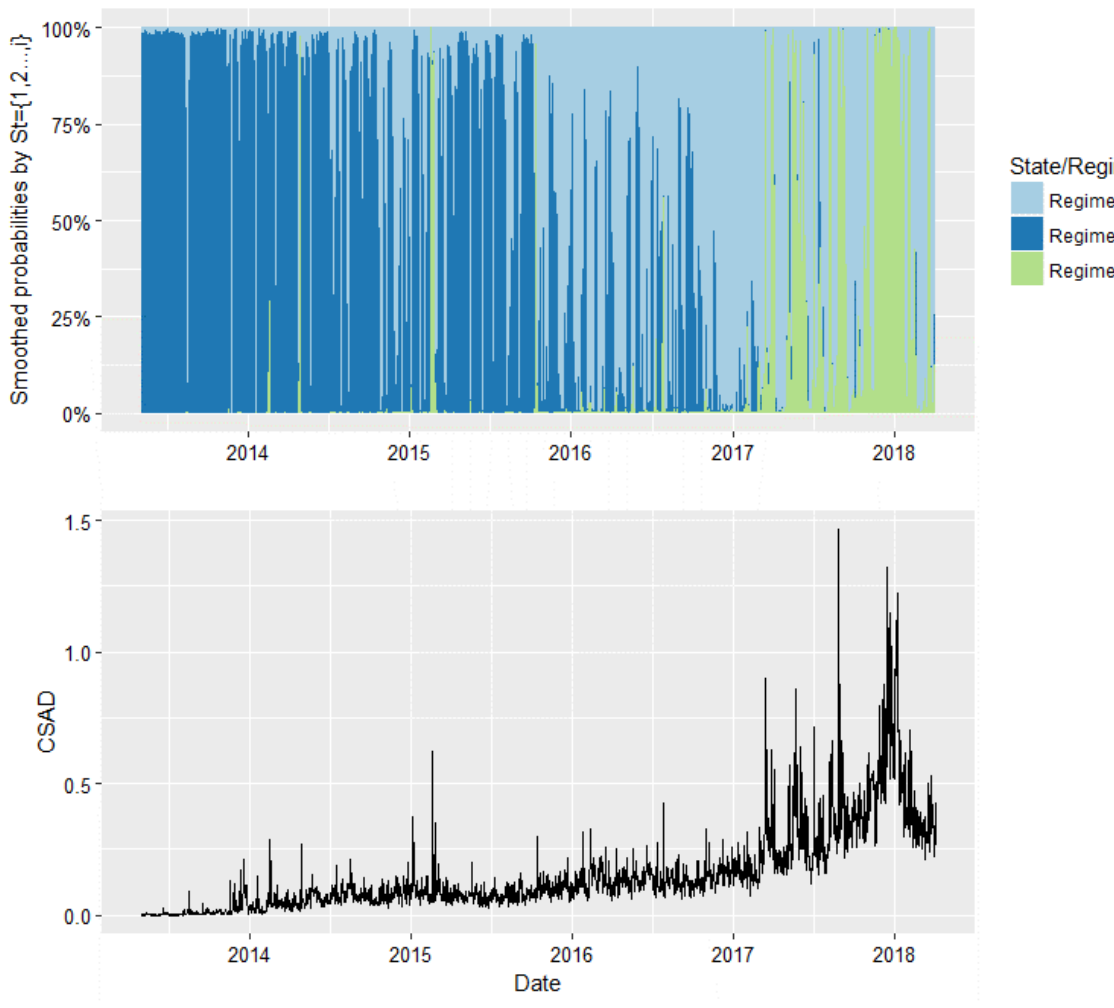
Figure 3: Regime switching smoothed probabilities under symmetric herding behavior for the full sample